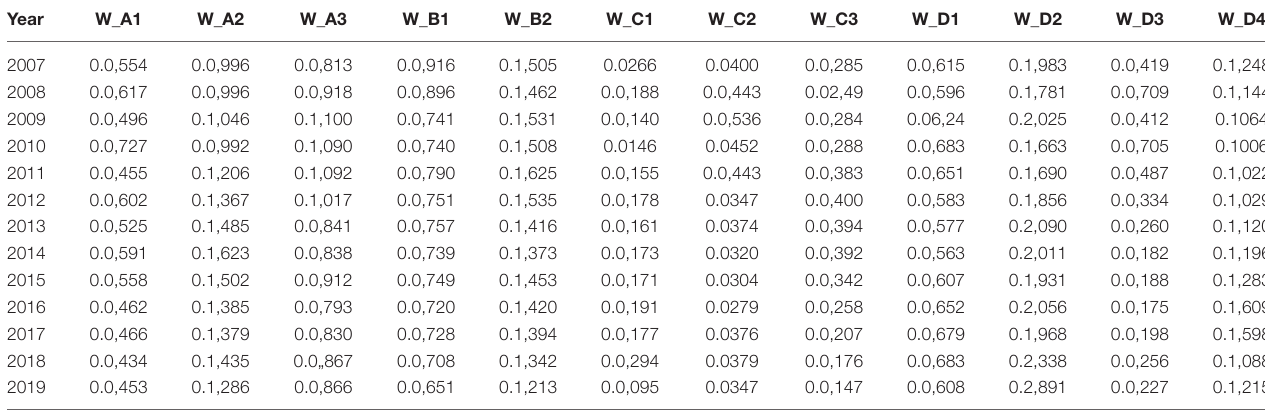
TABLE 2 | The weight of each index